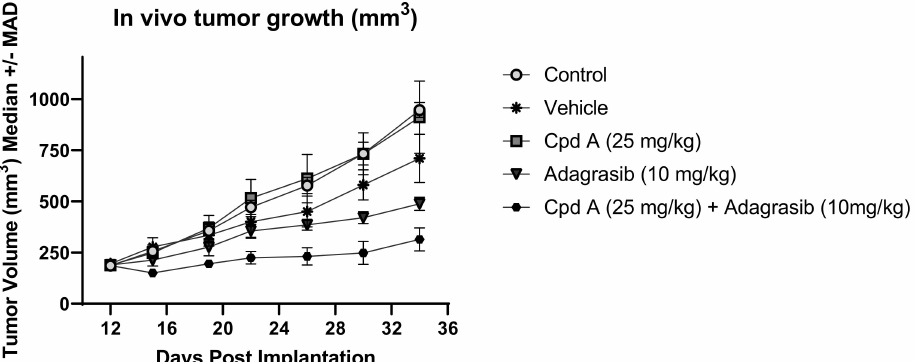
Figure 6. Sanofi internal Cpd A ameliorates adagrasib activity in tumor-bearing NCI-H358. Five conditions were analyzed: control, vehicle, Cpd A at 25 mg/kg, adagrasib at 10 mg/kg, and the combination of these last two compounds together. The treatments started 12 days after implantation, and samples were taken to compare the size of the tumors. Eight mice were used for each